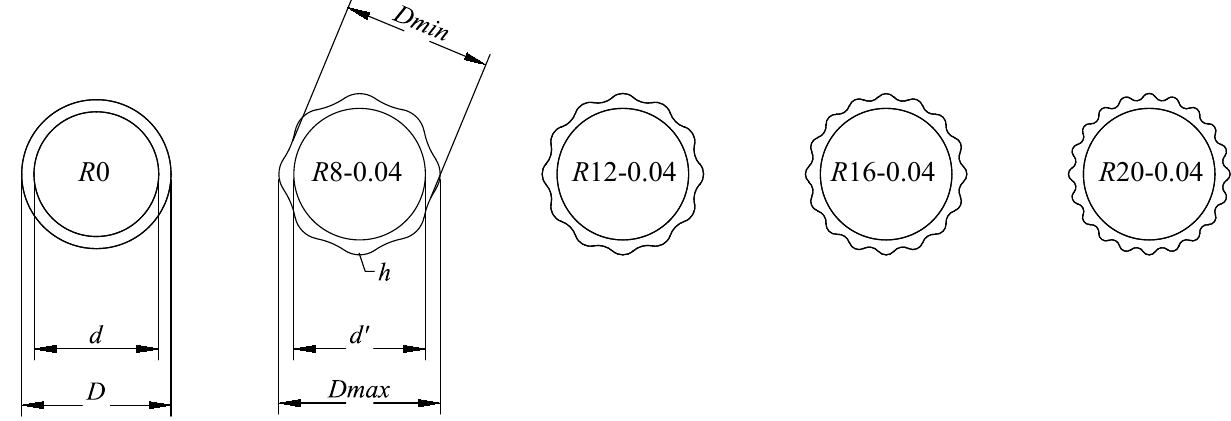
Figure 11. Sleeves of different cross-sectional shapes: circular R 0 and cactus-like R 8-0.04, R 12-0.04, R 16-0.04, R